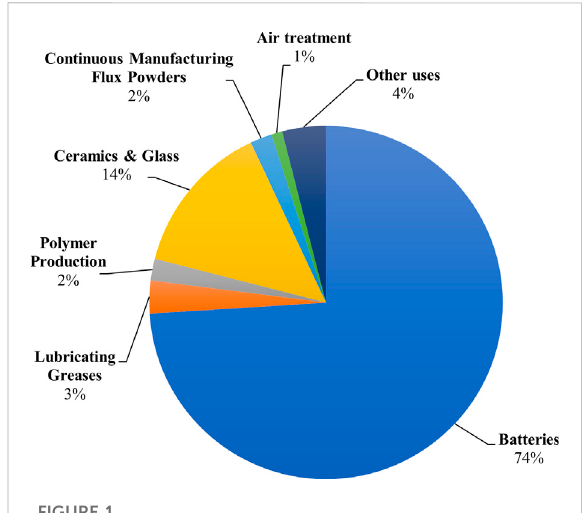
FIGURE 1 Pie chart showing market end uses of lithium as apercentage of global consumption in 2021 (U.S Geological Survey,